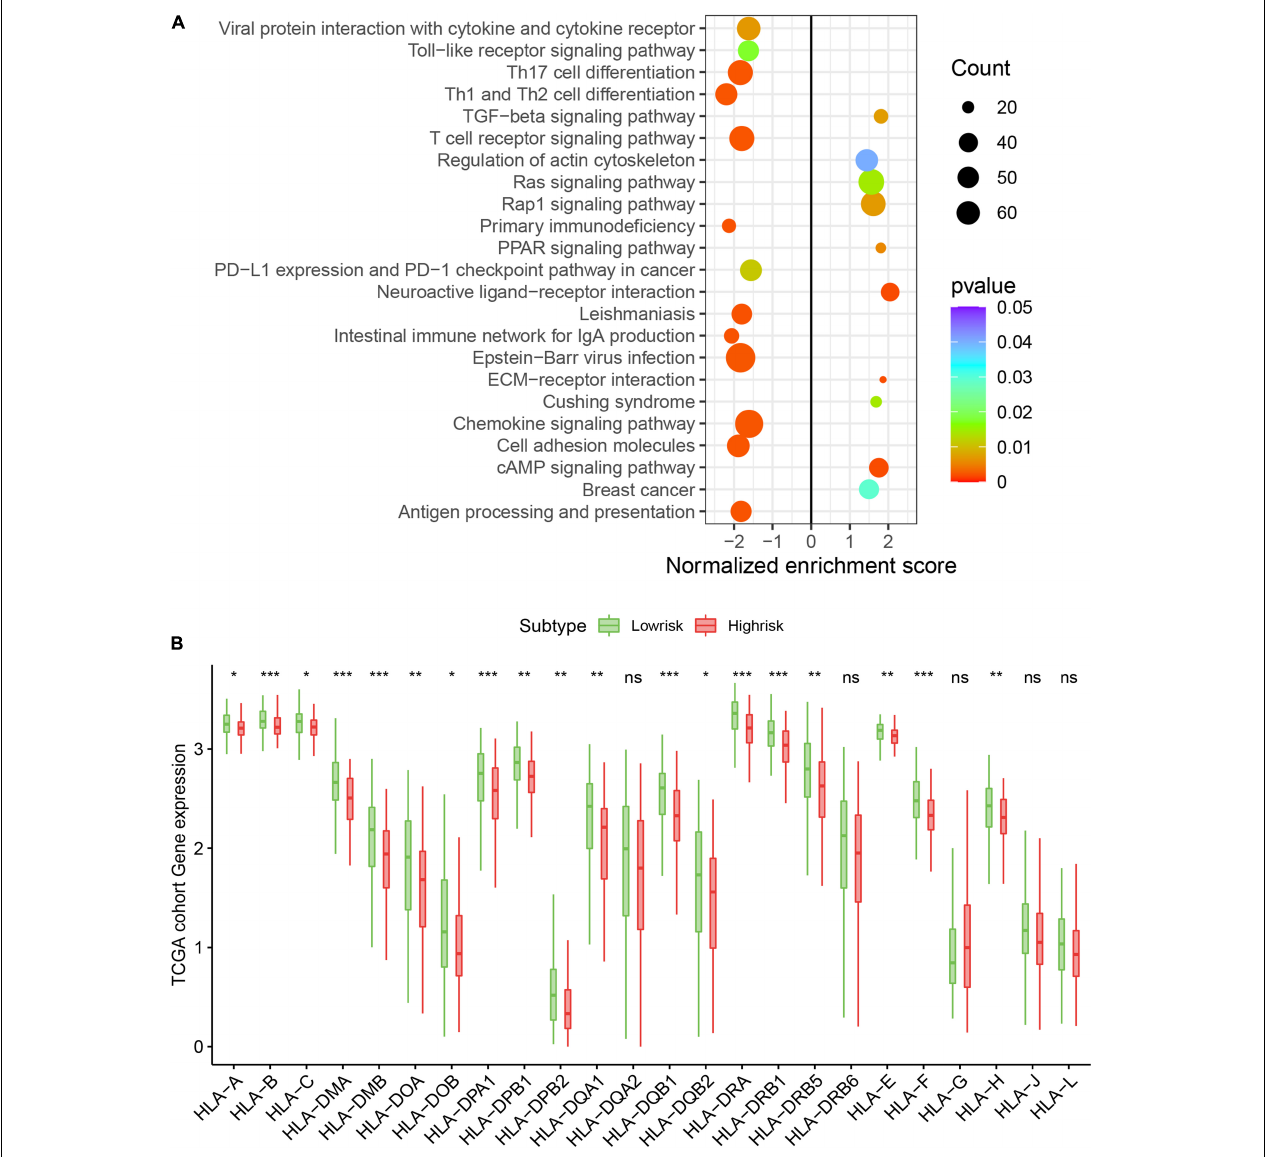
FIGURE 5 | Top enriched signaling pathways in distinct immune risk signature groups from the TCGA training cohort were assessed using the GSEA algorithm (A) . The immune risk signature was associated with human leukocyte antigen (HLA) (B) . * P < 0.05, ** P < 0.01, *** P < 0.001, ns P >